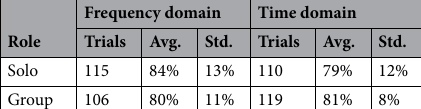
Table 1. Overall identification statistics.